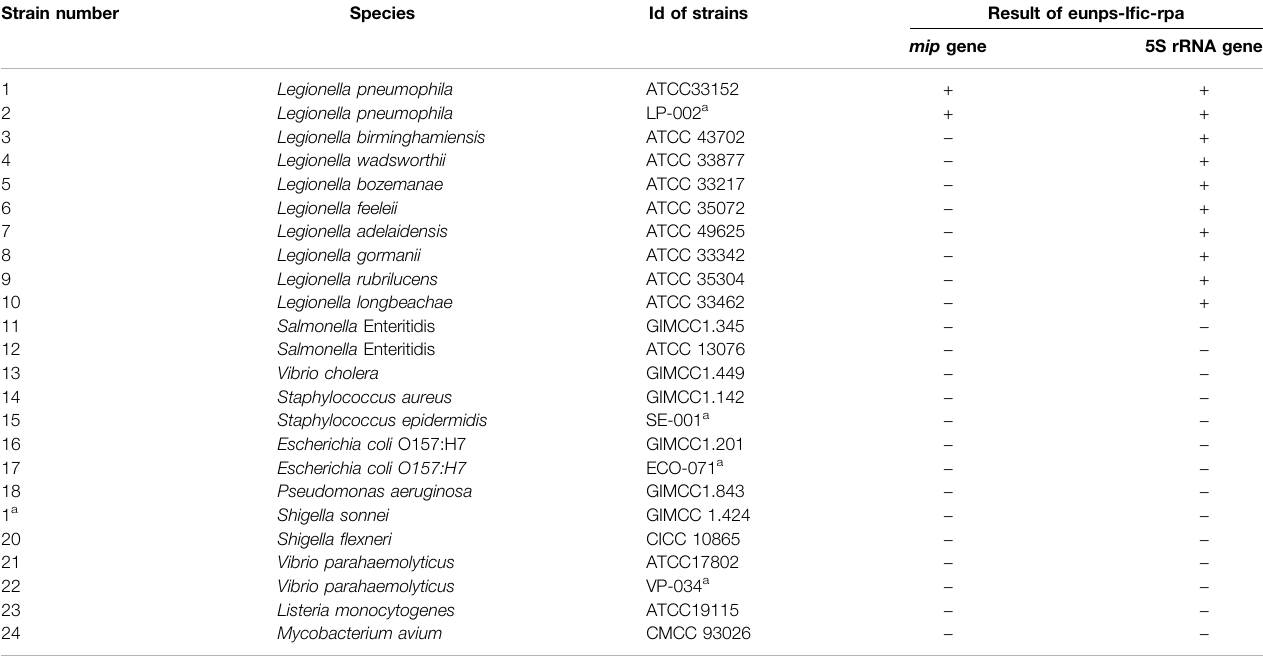
TABLE 1 | Information of bacterial strains used for speci fi city tests in the study. Strain